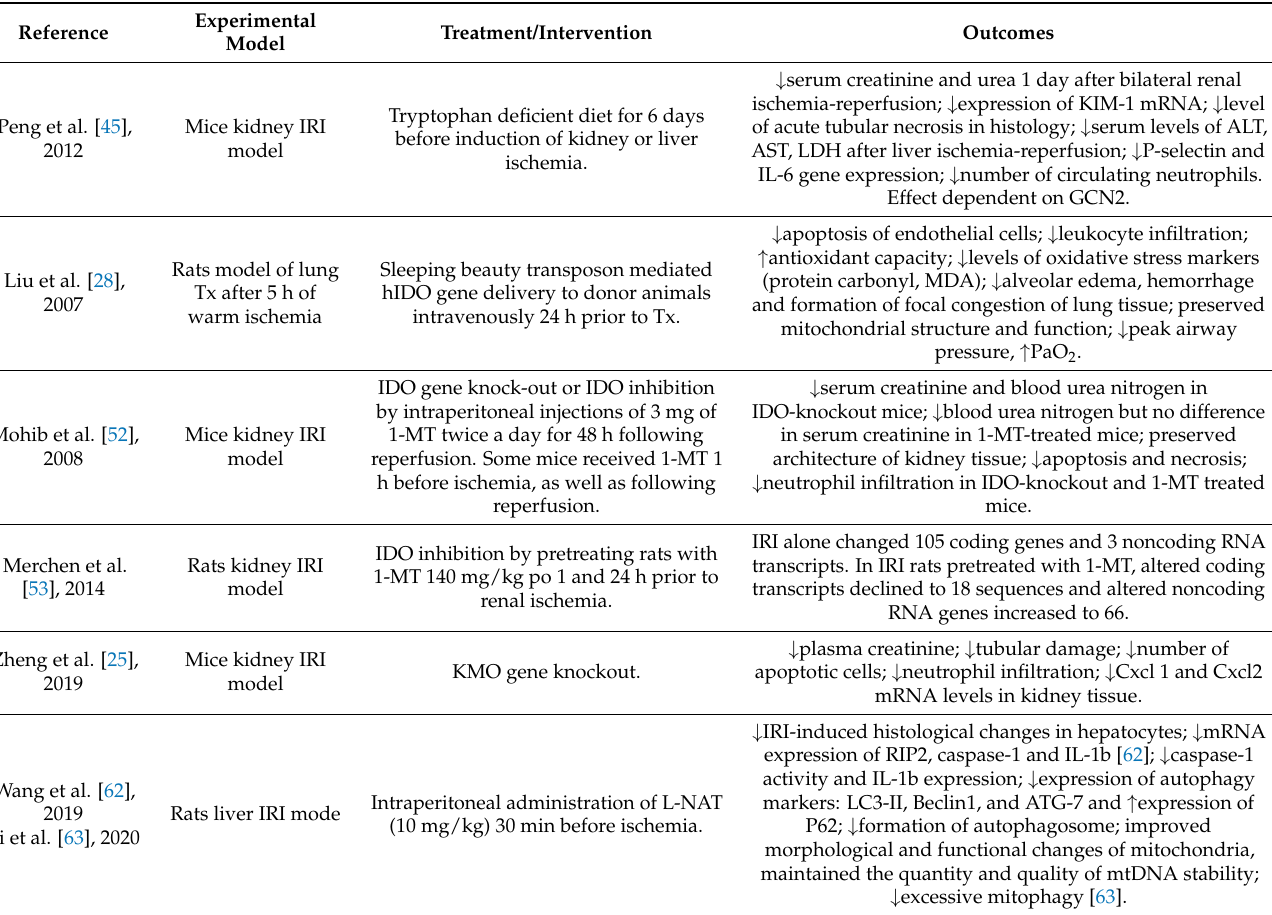
Table 1. Effects of tryptophan and its metabolism via the kynurenine pathway in solid organ IRI in animal